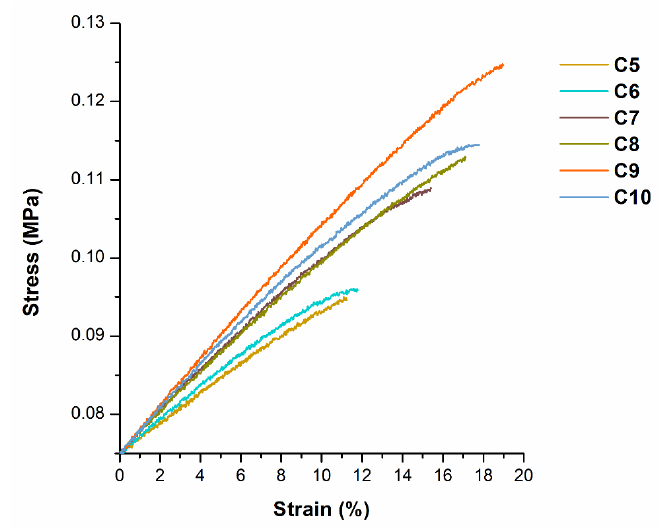
Figure 9. Tensile stress-strain curves of polymers C5 – C10 .